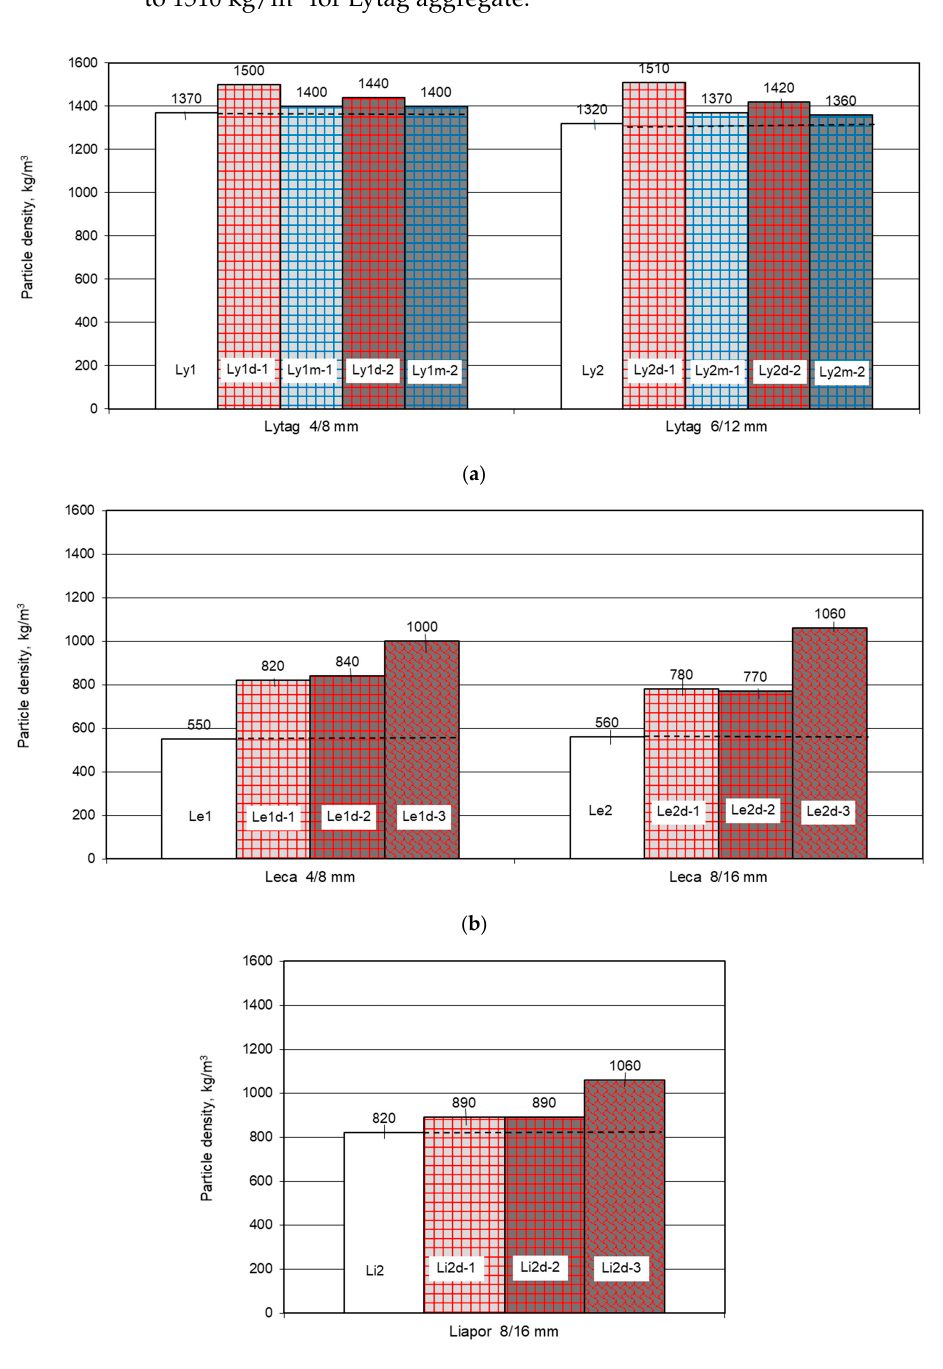
Figure 5. Mean oven dry particle density of lightweight aggregates, plain and impregnated with cement pastes: ( a ) Lytag, ( b ) Leca, ( c ) Liapor.